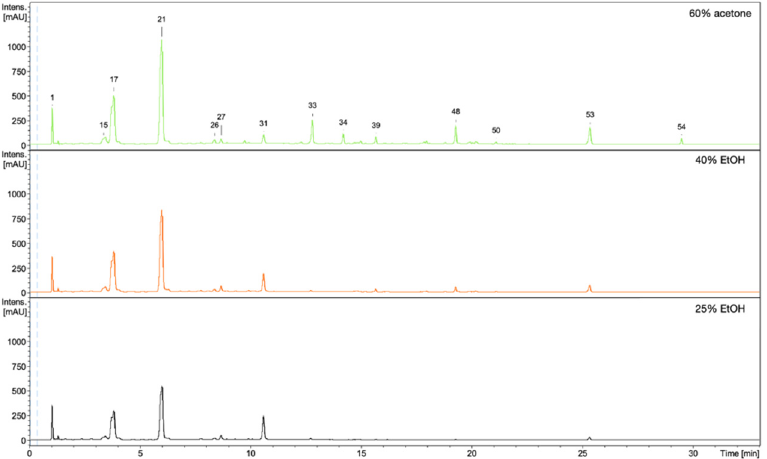
Figure 7. UV-HPLC chromatograms of 60% acetone, 40% EtOH, and 25% EtOH extracts from rhizomes of R. japonica with detection at 298 nm. Table 4. Linearity, LOD, LOQ data for used Table 3. Retention times, UV λ max, MS data, and ion formula suggestion of the constituents present in the extracts of R. japonica rhizomes.